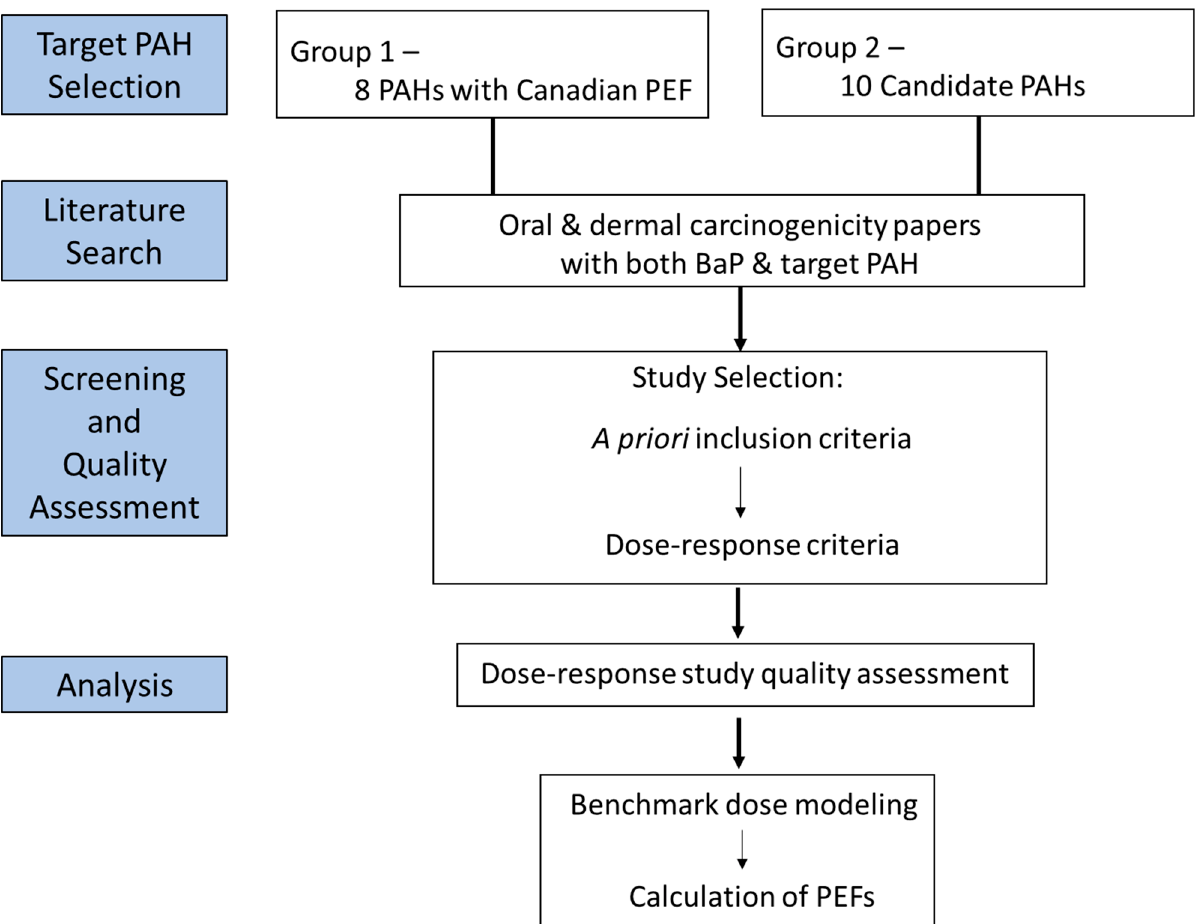
Figure 1. Conceptual Model of Approach to Data Gathering and Analysis.